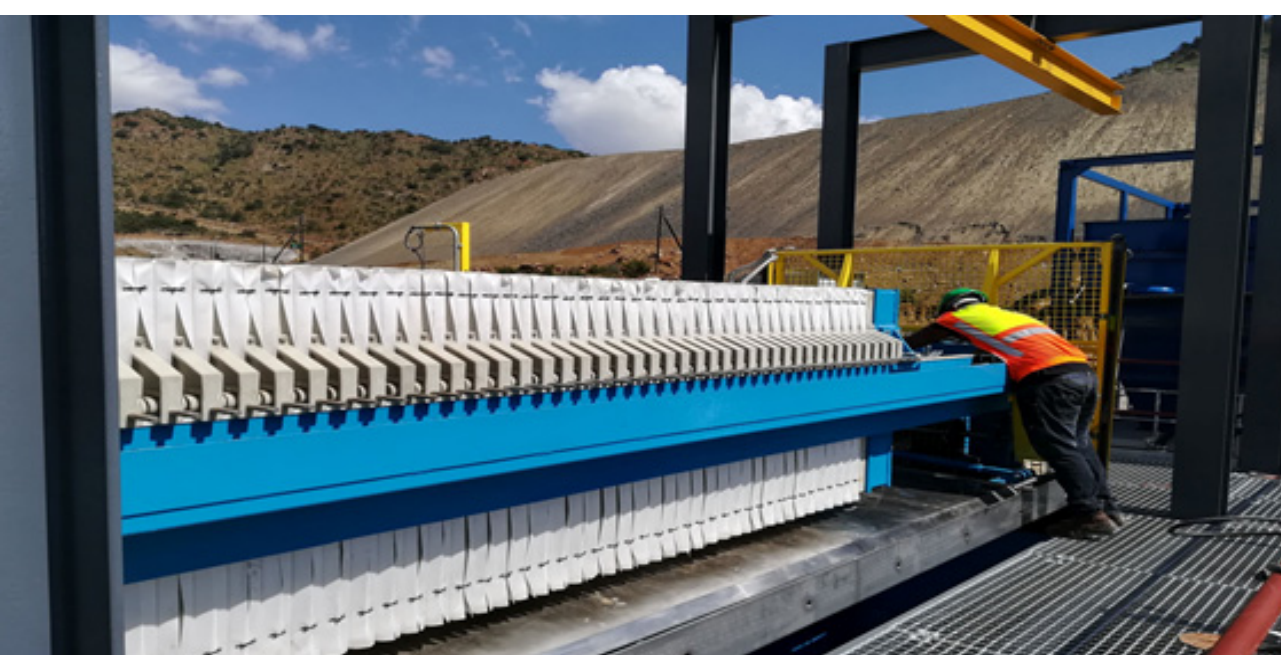
Figure 4. Typical Tailings Vertical Plate and Frame Automatic Filter Press [9].